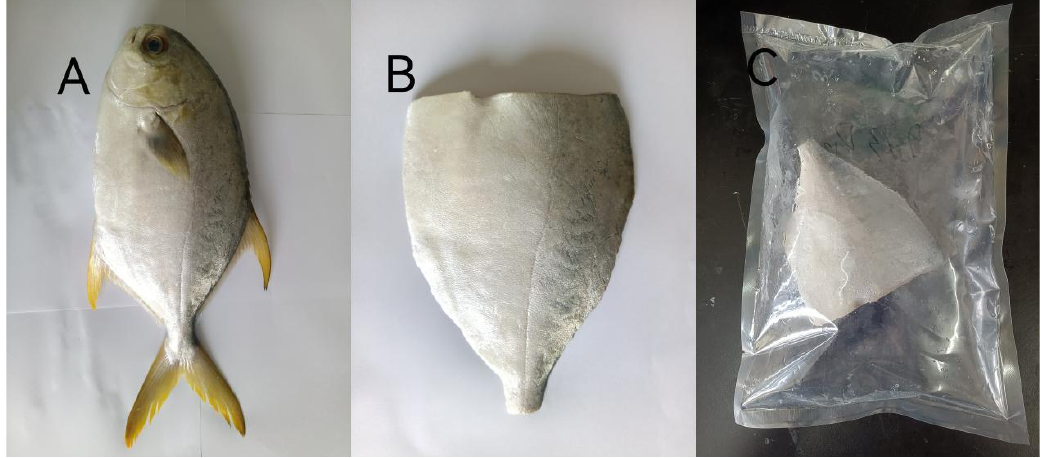
Figure 1. Images of golden pompano ( A ), fillet sample ( B ) and packaging method ( C ). The samples were taken at 0, 5, 10, 15, 20, 25 and 30 days after storage and analyzed for changes in muscle hardness, elasticity, CO 2 solubility, whiteness, APC, pH, TVB-N, TBARs and water retention capacity.